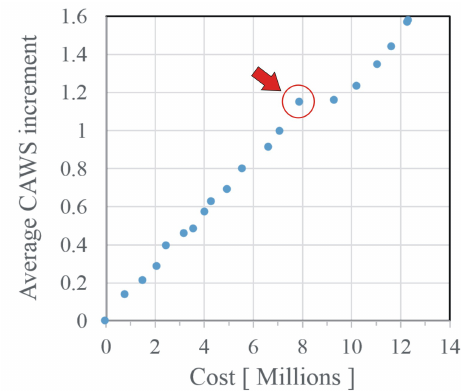
Figure 4. The estimated Pareto front. The selected solution is highlighted in the graph and the map on Figure 5 shows the corresponding buildings object of transformation.